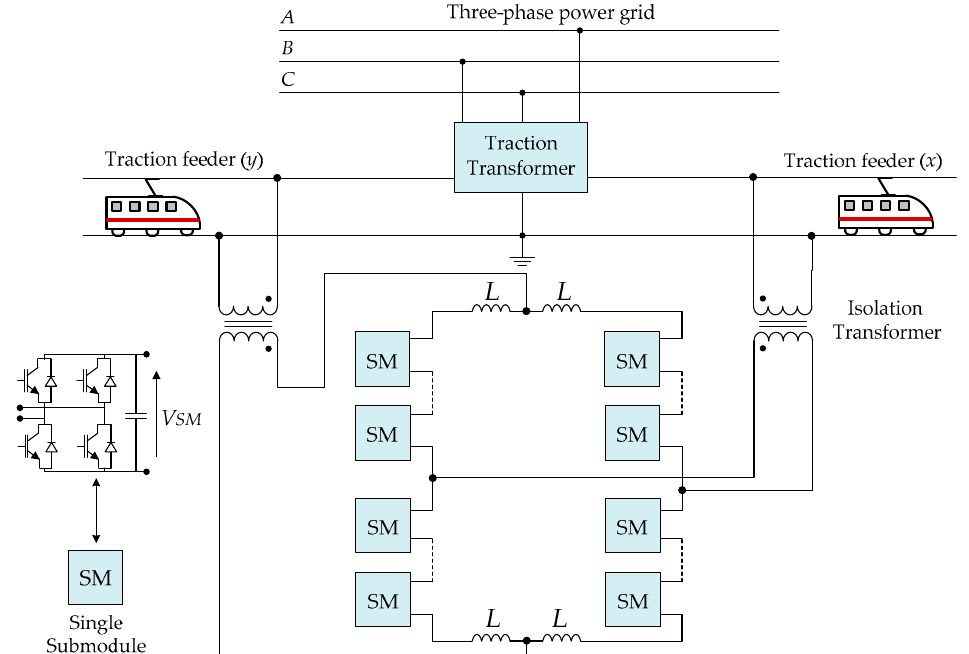
Figure 17. RPC based on direct modular multilevel converter (FB-MMC2 RPC) with isolation transformers (based on [33]).